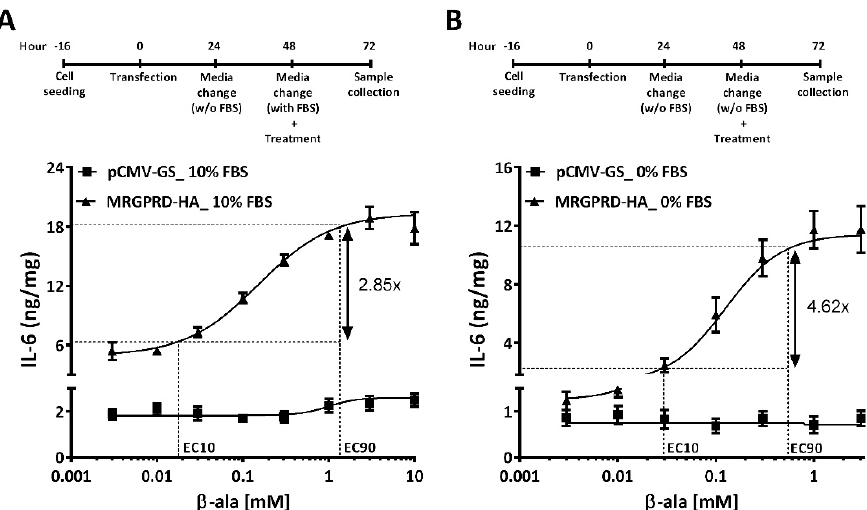
Figure 5. Concentration–effect curves of β -alanine obtained in the presence or absence of FBS. HeLa cells expressing the empty vector (pCMV-GS; square symbol) and MRGPRD-HA (triangle symbol) were treated with increasing concentrations of β -alanine in the absence or presence of FBS. Cells expressing MRGPRD induced the release of IL-6 in a concentration-dependent manner when treated with β -alanine with FBS ( A ) or without FBS ( B ). A higher basal activity of MRGPRD was observed in cells treated under FBS conditions as compared to non-FBS conditions. No significant IL-6 release was observed from cells expressing the empty vector (pCMV-GS). The dynamic range obtained when cells were treated in FBS ( A ) conditions was 2.85, whereas it increased to 4.62 when cells were treated in FBS-free conditions ( B ). Each graph represents the mean ± s.e.m values from at least three independent experiments.